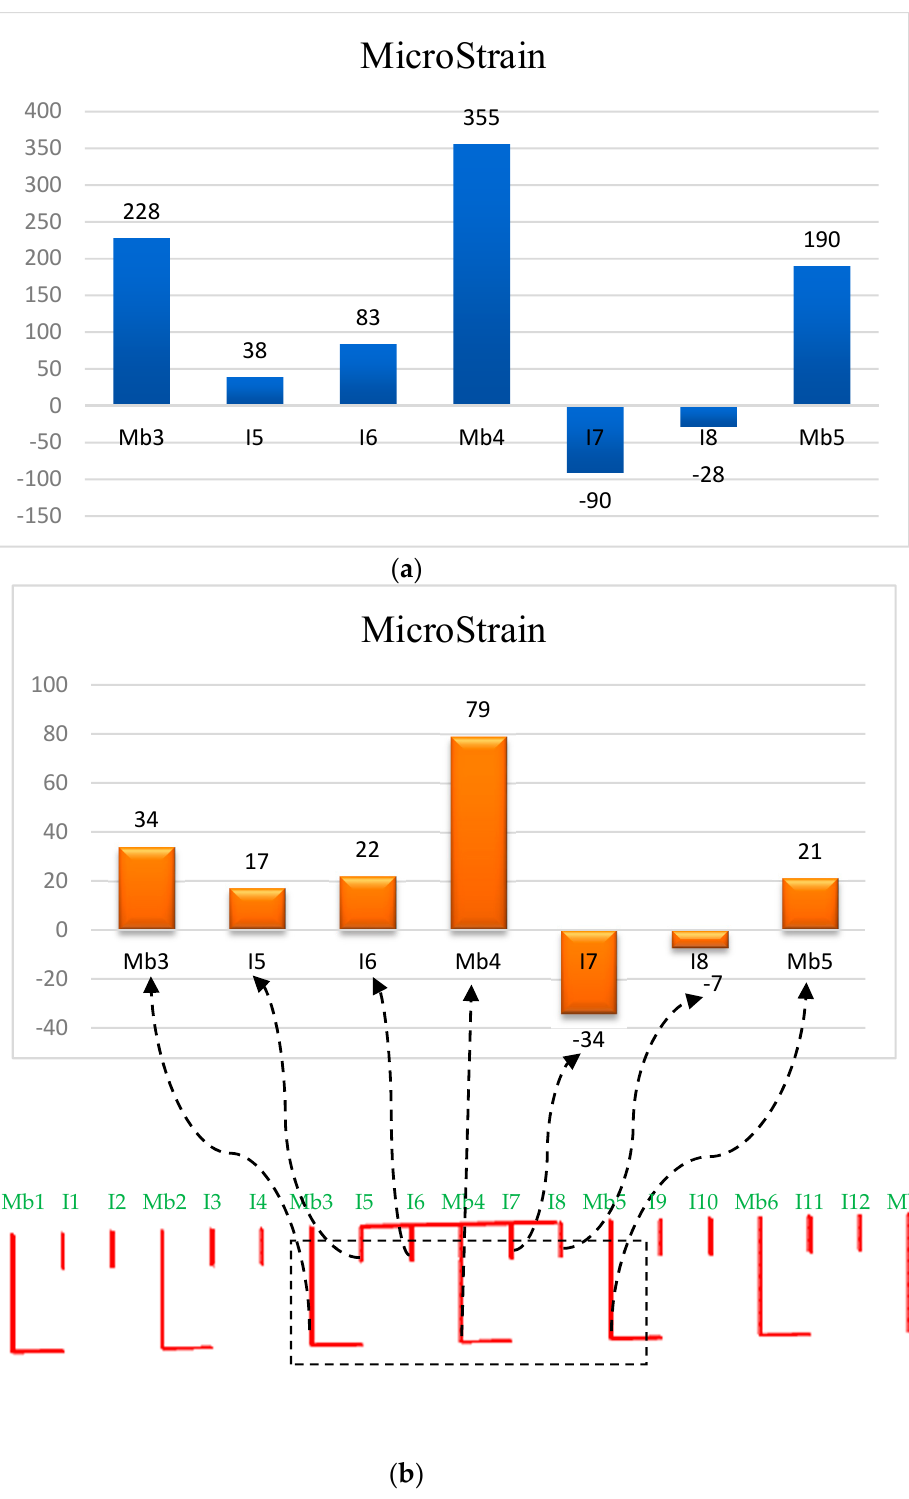
Figure 8. Strain distribution of the most critical components ( a ) at the midspan ( b ) over the interior support. Note: 1 microstrain = 10 − 6 in/in, mm/mm.